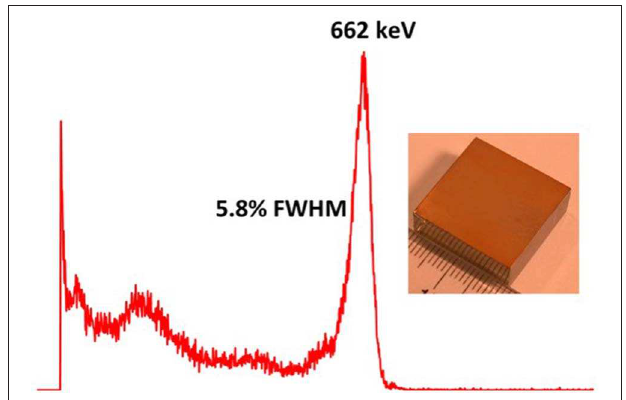
FIGURE 6 | 137 Cs spectrum obtained from a 20 × 20 × 8mm planar detector.